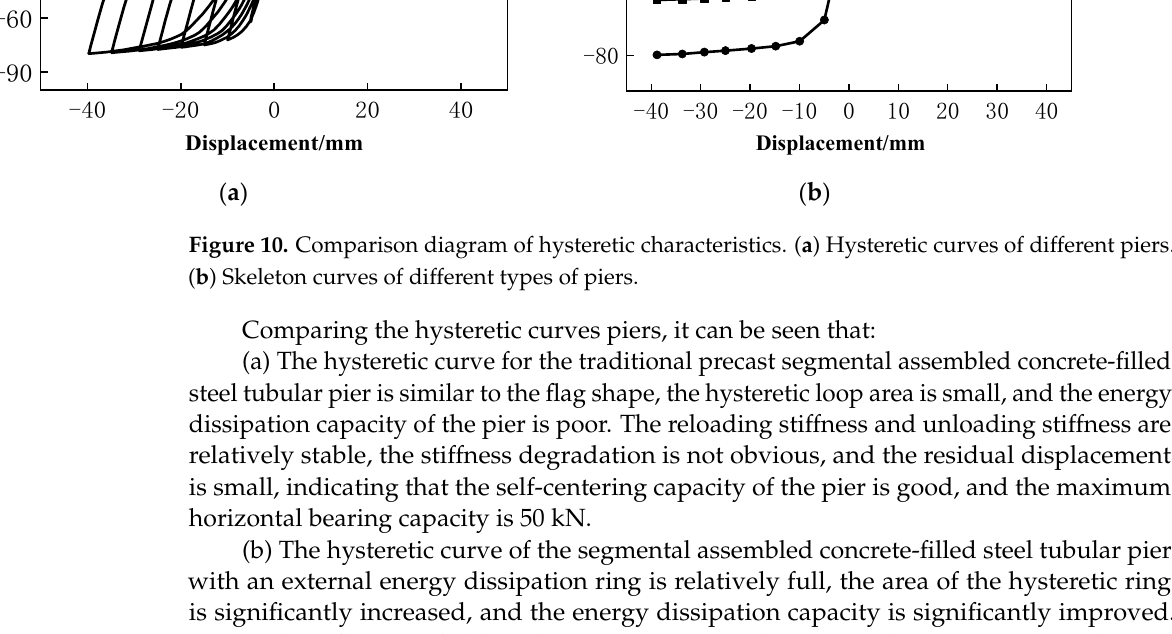
Table 4. Performance turning point of skeleton curve.